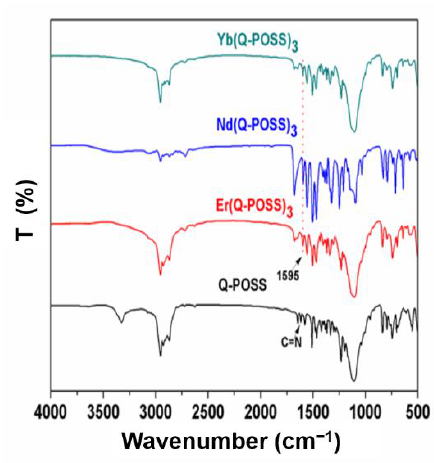
Figure 1. The FT-IR spectra of Yb(Q-POSS) 3 , Nd(Q-POSS) 3 , Er(Q-POSS) 3 , and Q-POSS.